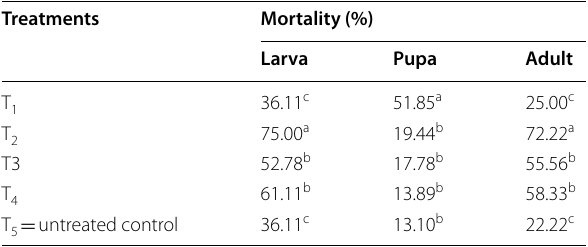
Table 1 Effect of different treatments against P. 14-punctata under laboratory conditions